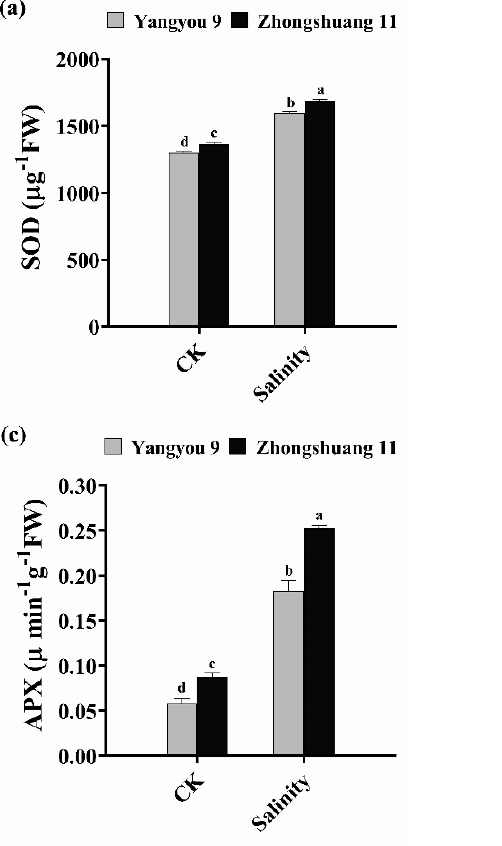
Figure 5. Modifications in ( a ) superoxidase (SOD), ( b ) peroxidase (POD), ( c ) ascorbate peroxidase (APX), and ( d ) catalase (CAT) activity under normal and salt conditions induced by 150 mM NaCl on fresh samples. Bars represent ± SE of three replicates. Letters (a, b, c and d) on vertical bars represent significant differences between cultivars and treatments according to Duncan’s multiple range test (DMRT) at p < 0.05.